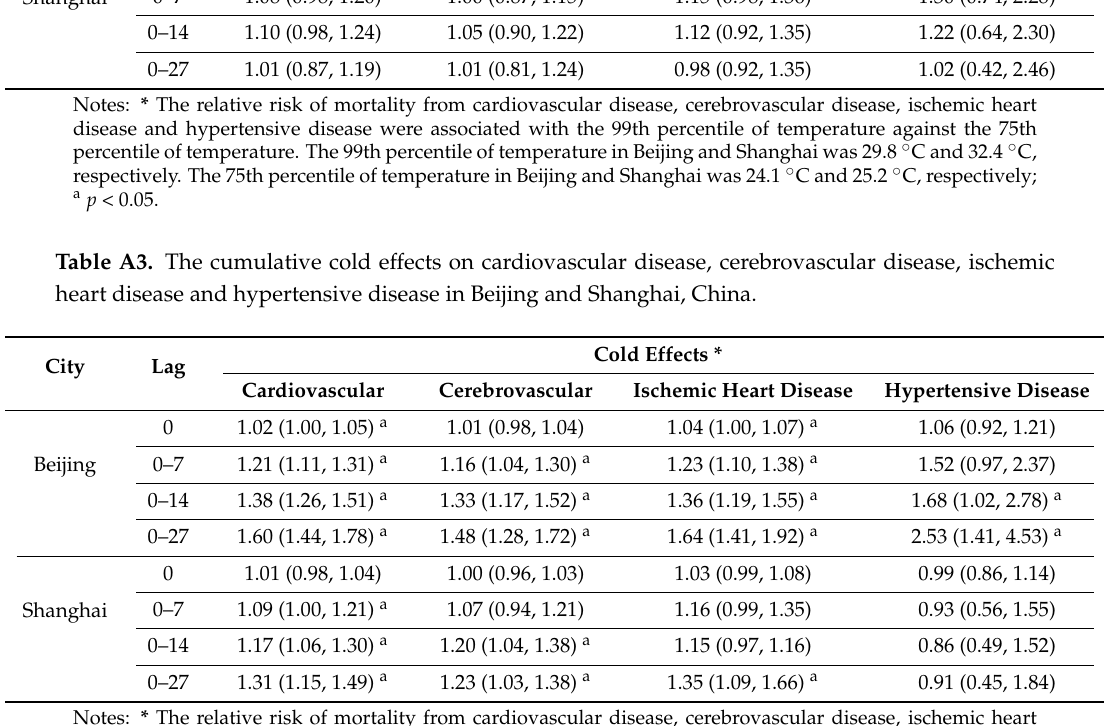
Table A2. The cumulative hot effects on mortality from cardiovascular disease, cerebrovascular disease, ischemic heart disease and hypertensive disease in Beijing and Shanghai, China. Hot Effects * City Lag Cardiovascular Cerebrovascular Ischemic Heart Disease Hypertensive Disease Beijing